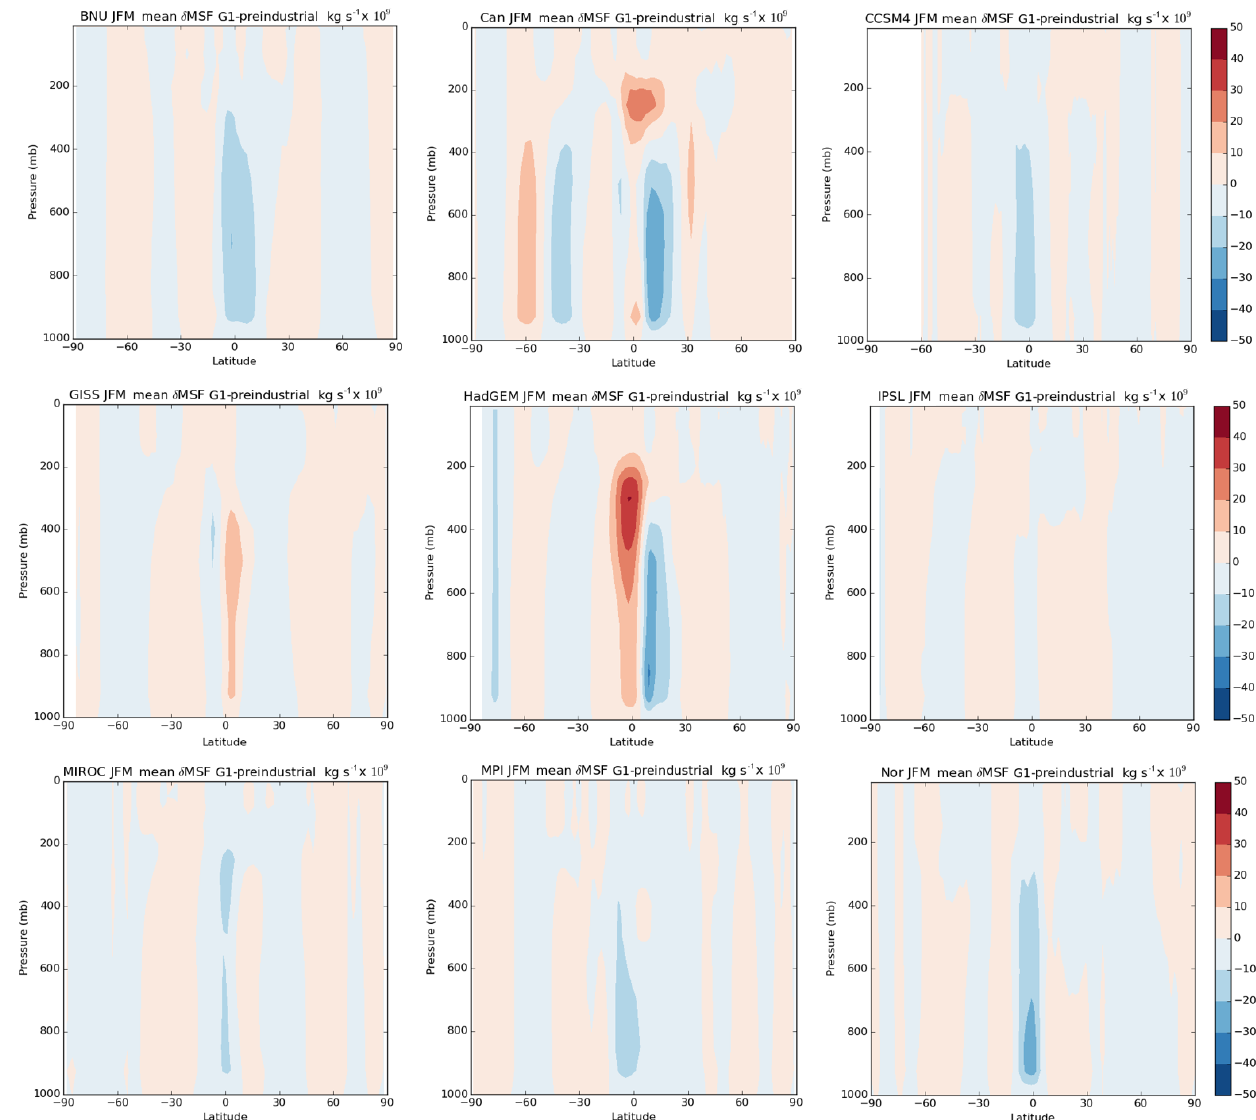
Figure 8. The JFM mean meridional stream function anomaly between G1 (years 11–50) and piControl (last 40 years) in each model, as calculated in Eq. (4). The blue coloring indicates counterclockwise motion (data unavailable for HadC and CESM